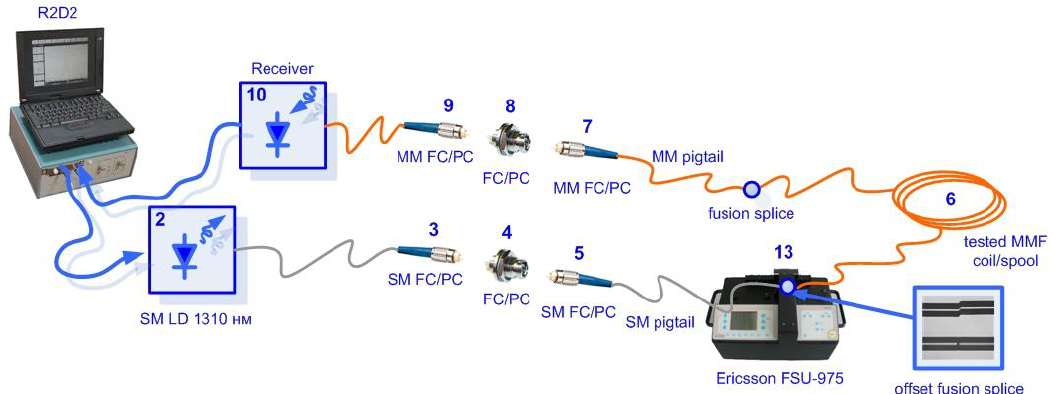
Figure 9. Simplified block scheme of DMD analyzer workstation R2D2.